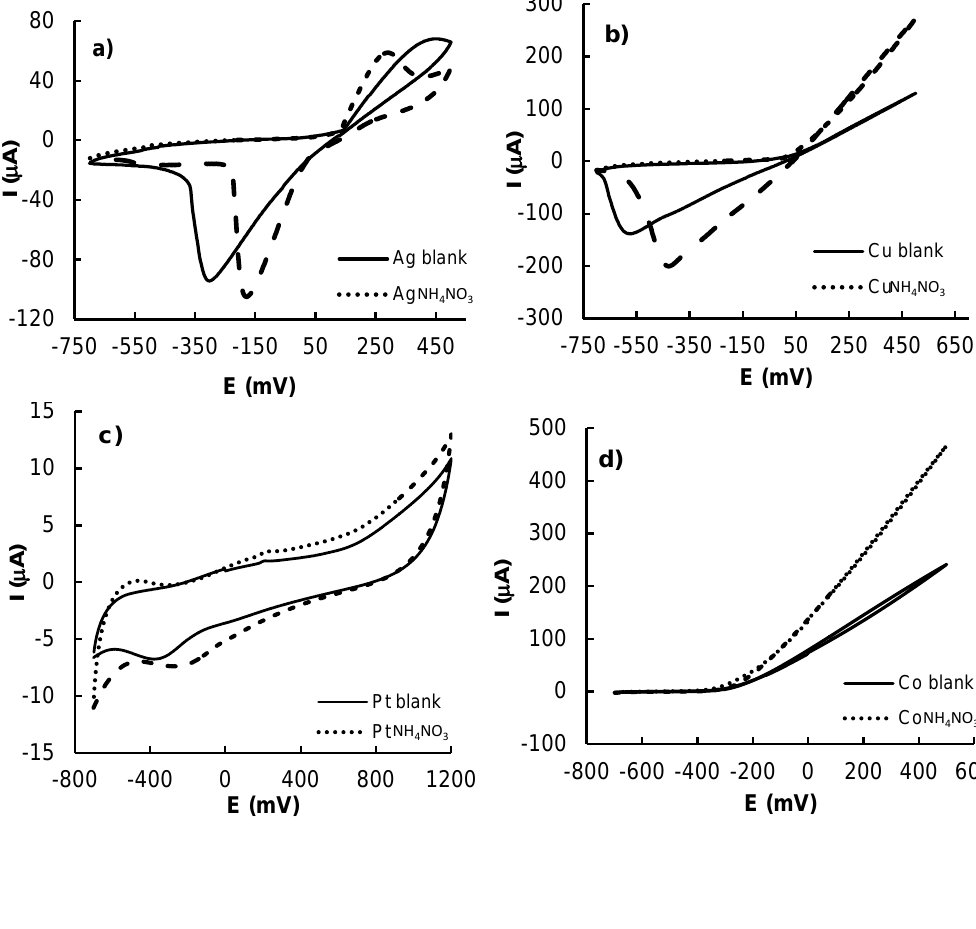
Figure 2. Cyclic voltammograms of the solvent (pH 7 buffered with 0.01 mol·L −1 phosphate buffer (solid line) and of 0.001 mol·L −1 NH measured at 100 mV·s −1 using silver ( a ), copper ( b ), platinum ( c ), cobalt ( d ) and nickel ( e